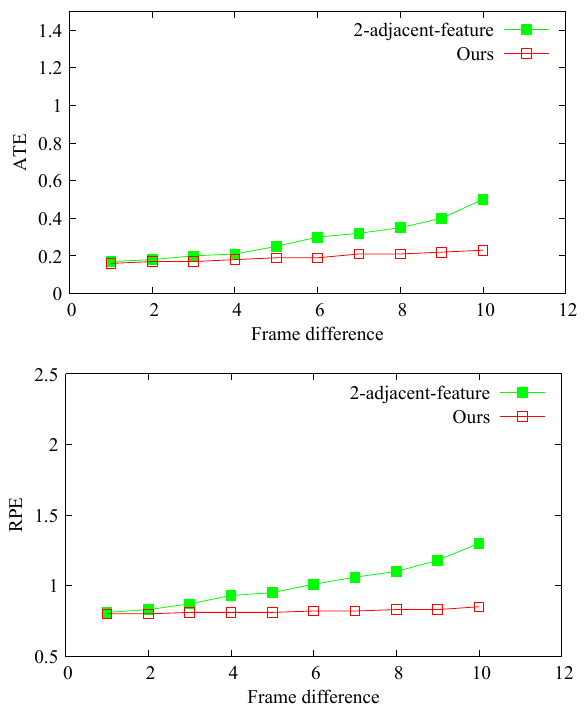
Fig. 9 Comparison between our method and the consecutive-feature method on fr1/floor for varying frame